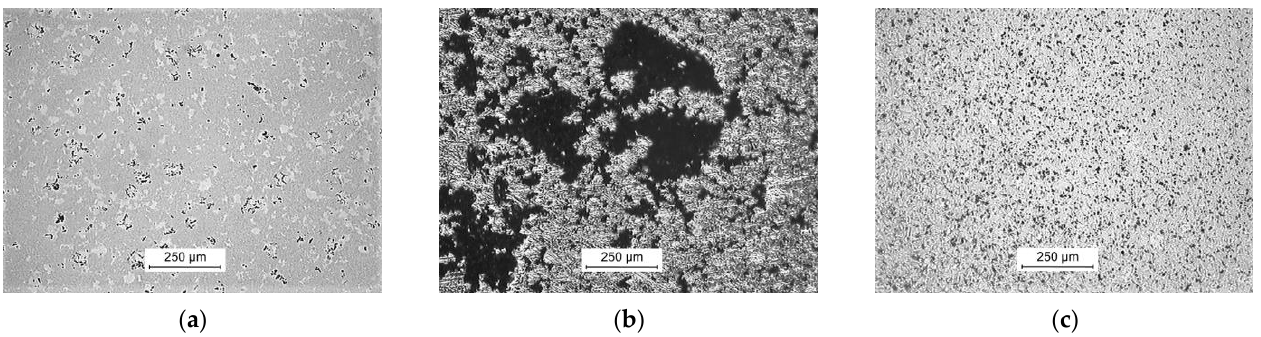
Figure 3. Optical images of the surfaces of composite samples after polishing process: ( a ) Group I (Ti-TiB 2 , 1250 °C); ( b ) Group II (Ti6Al4V-TiB 2 , 1050 °C); ( c ) Group III (Ti-B, 1350 °C).